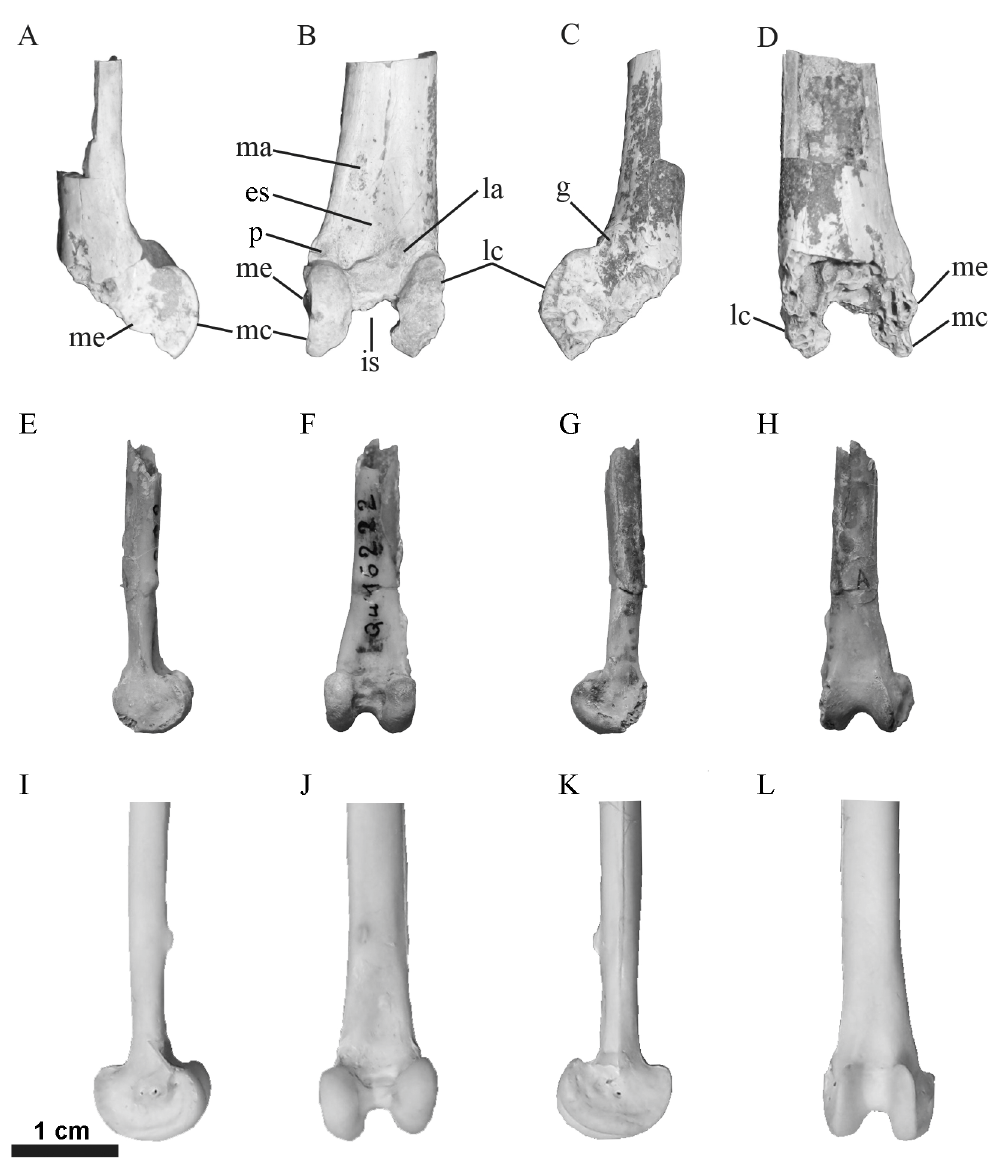
Figure 2. Distal left tibiotarsi of: the Jebel Owl (DPC 24780); the holotype specimen of Selenornis henrici (MNHN QU-16222); and Tyto alba (CU 1827) in medial ( A , E , I ), cranial ( B , F , J ), lateral ( C , G , K ), and caudal ( D , H , L ) views. Anatomical abbreviations: es- extensor sulcus, g-groove and depression adjacent to lateral condylar notch, is-intercondylar sulcus, la-lateral attachment of the